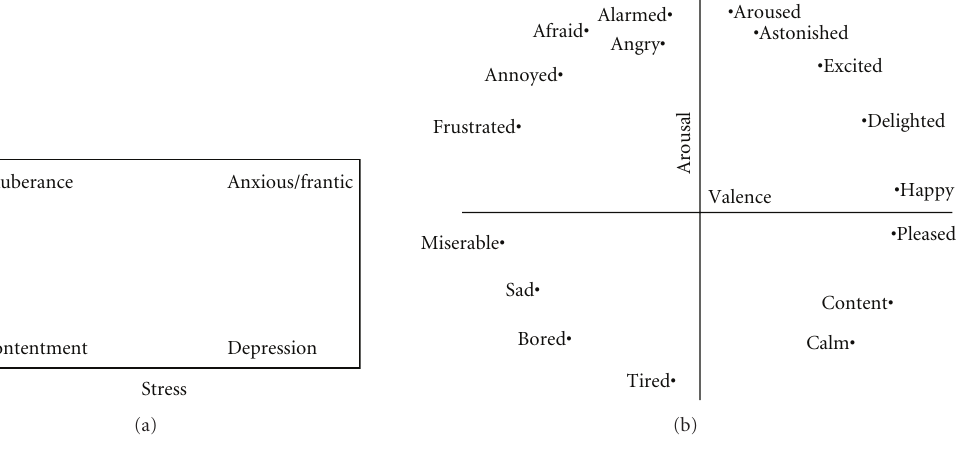
Figure 2: Emotion spaces: (a) Thayer, (b) Russell.